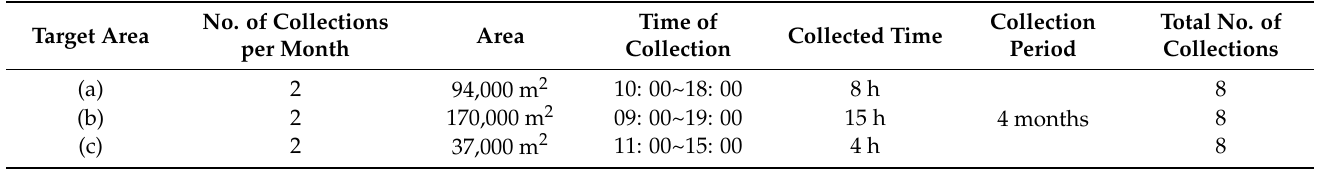
Table 1. Number of data